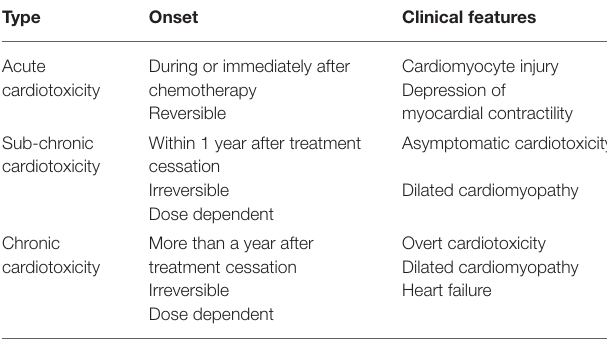
TABLE 2 | Characteristics of